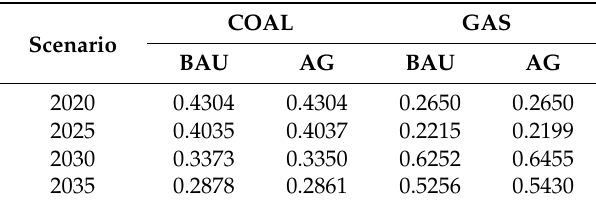
Table 15. Comparison of the load factors for coal and gas between the BAU and AG reserve capacity adjustment